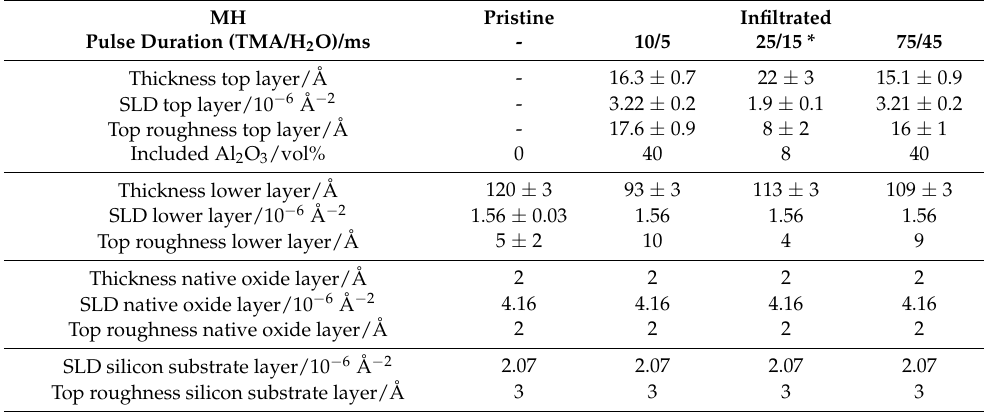
Figure 4. Neutron reflectometry data, showing effect of precursor pulse duration in semi-static infiltration of TMA/H 2 O into MH. ( a ) Neutron specular reflectivity profiles, showing measured data with error bars, and fitted models as solid lines, and ( b ) fitted neutron SLD as a function of distance from substrate, where z = 0 represents the interface between silicon and native oxide. Table 4. Effect of precursor pulse duration in semi-static infiltration of TMA/H 2 O into